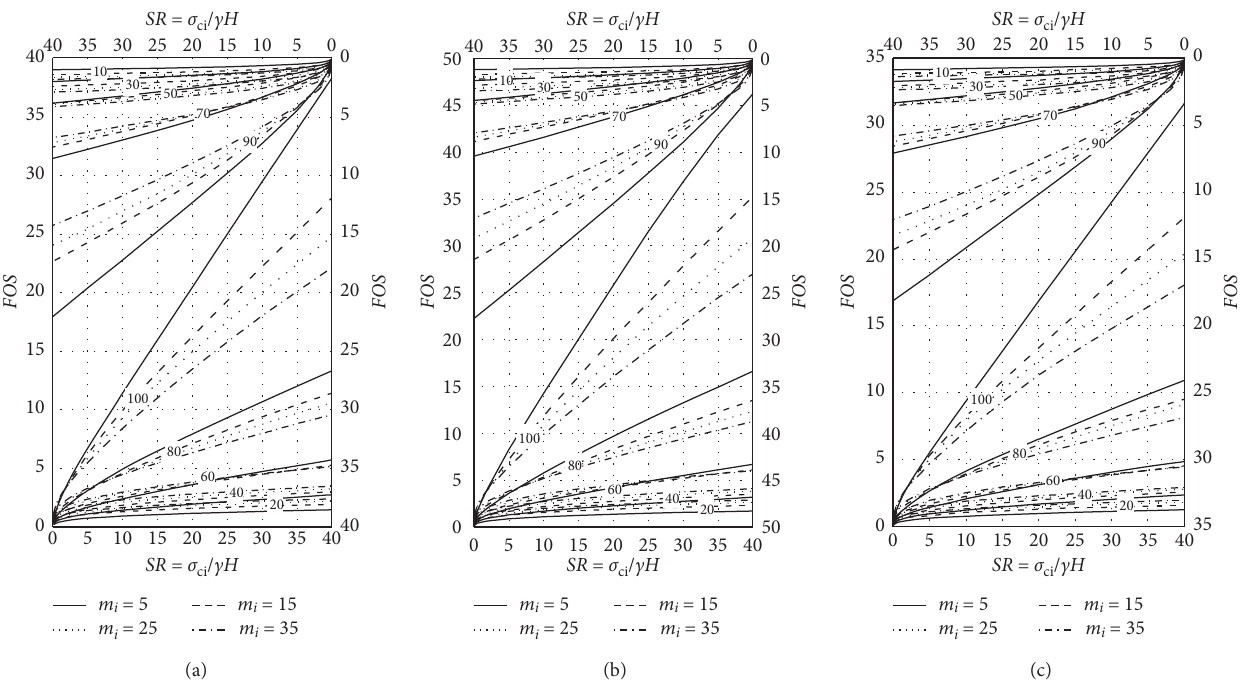
Figure 7: Stability charts for rock slopes with β � 45 ° under pseudostatic condition: (a) k the biaxial coordinate is adopted to differentiate the trends of curves with different GSI values in one